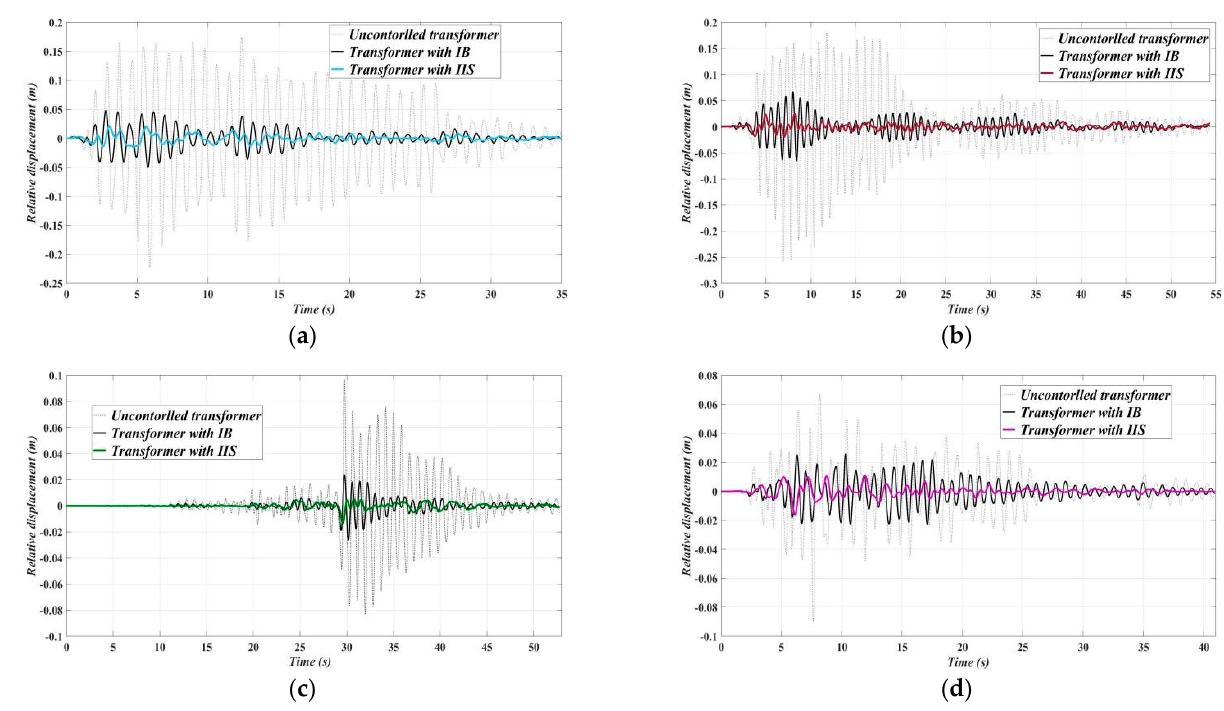
Figure 17. Relative displacement responses of bushing (LB–2): ( a ) EL Centro; ( b ) Taft; ( c ) Chi–Chi; ( d ) Kobe.